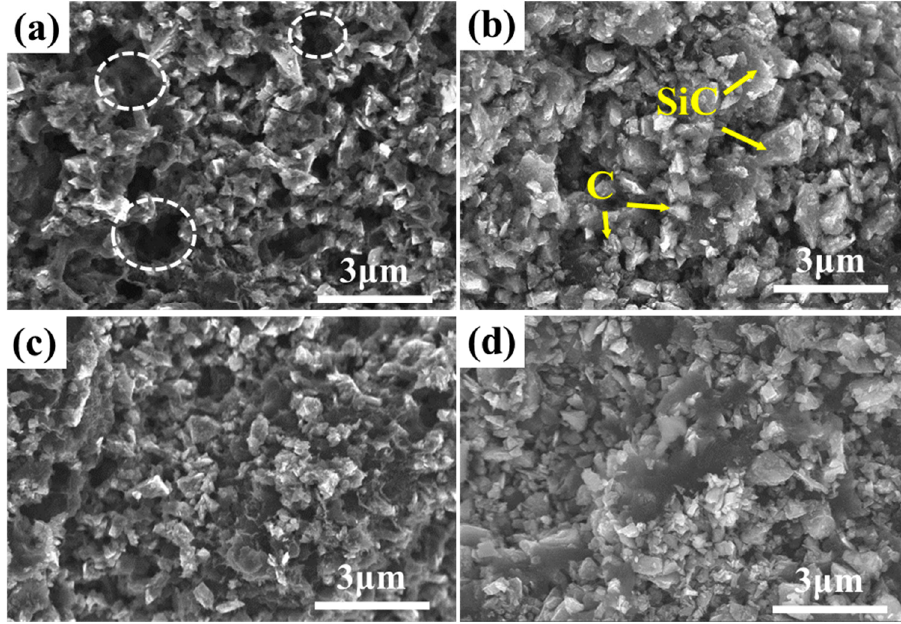
Figure 5. Microstructure of the phenolic resin pyrolysis with different solid loading: ( a ) 8%; ( b ) 13%; ( c ) 19%; ( d ) 26%.